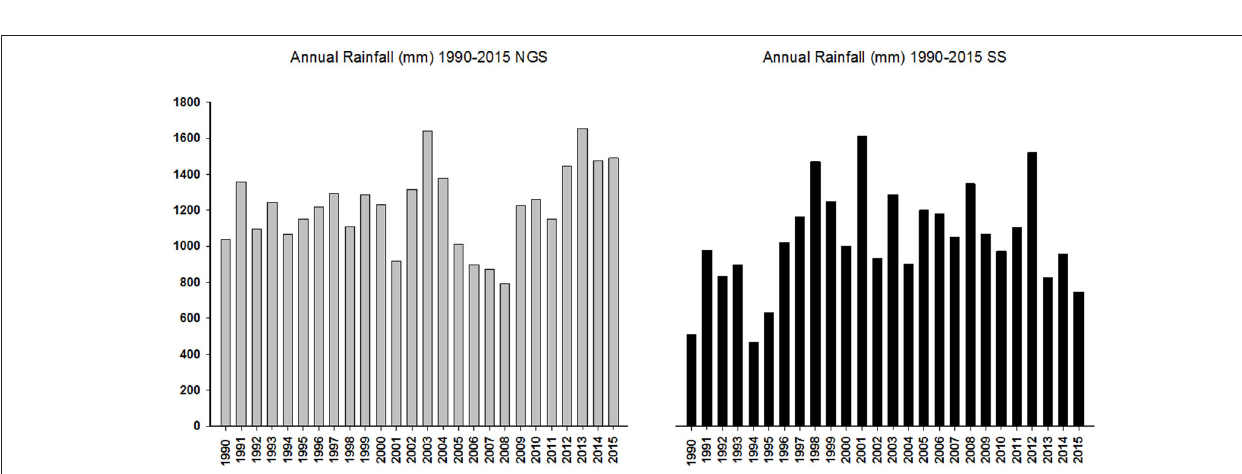
FIGURE 1 | Total rainfall, mean, minimum, and maximum temperature and mean solar radiation for calibration sites: (A) BUK 2014; (B) Dambatta 2014; (C) BUK 2015; (D) BUK 2015.